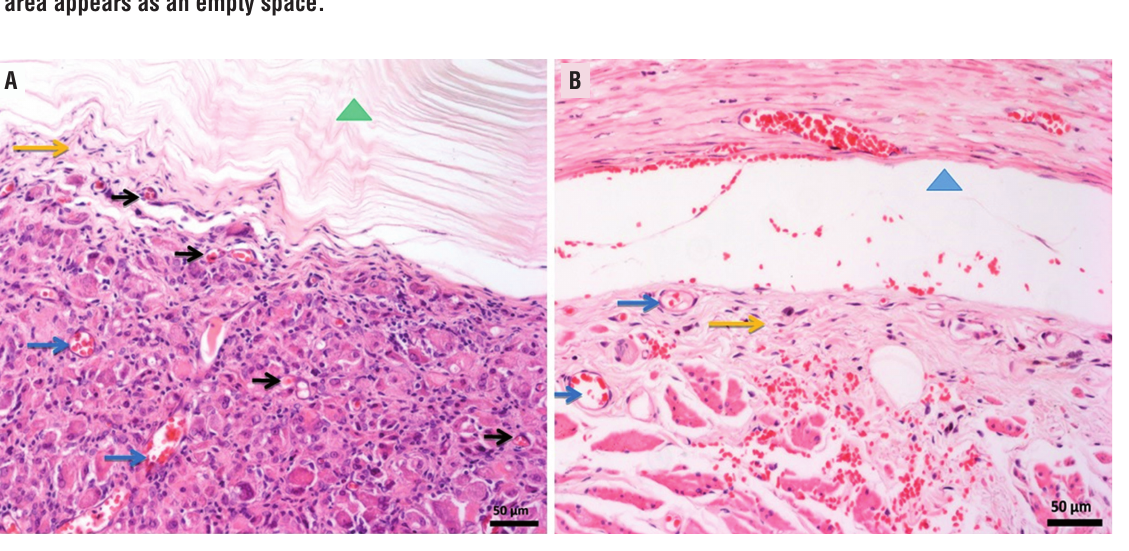
Figure 2 - Photomicrography of the implant-tissue interface. A) Bacterial Cellulose group and B) Silicone group after 8 months. ( ∆ ) BC) ( ∆ ) Area where the silicon implant had occupied; ( → ) Blood vessels; ( → ) vascular congestion; ( → ) inflammatory cells. Staining with hematoxylin and eosin. Note: Silicone implants did not resist the histological processing, for that reason the area appears as an empty space.